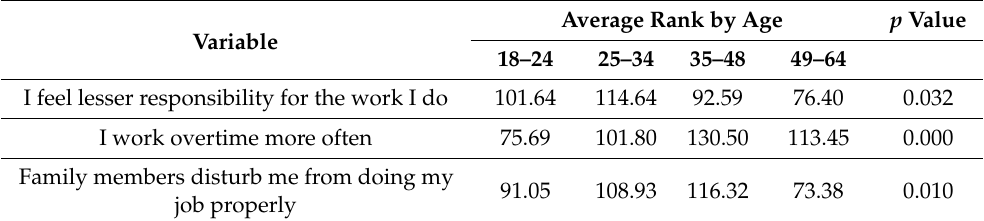
Table 4. The effect of teleworking by age.